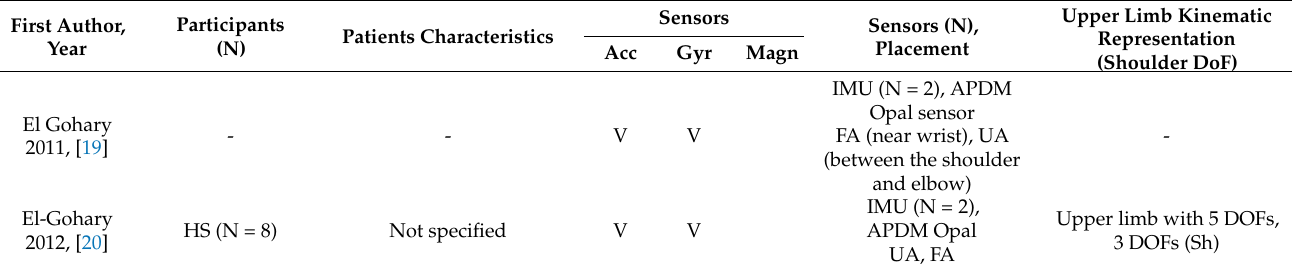
Table 1. Characteristics of the studies